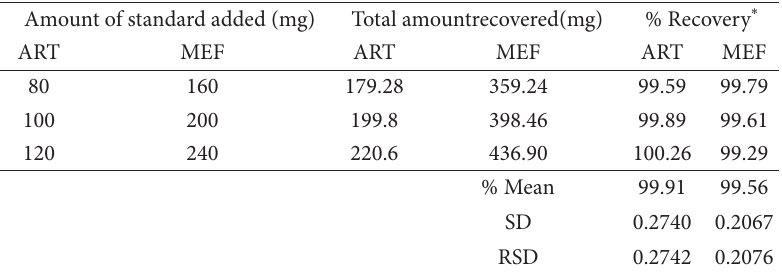
T 6: Results of recovery